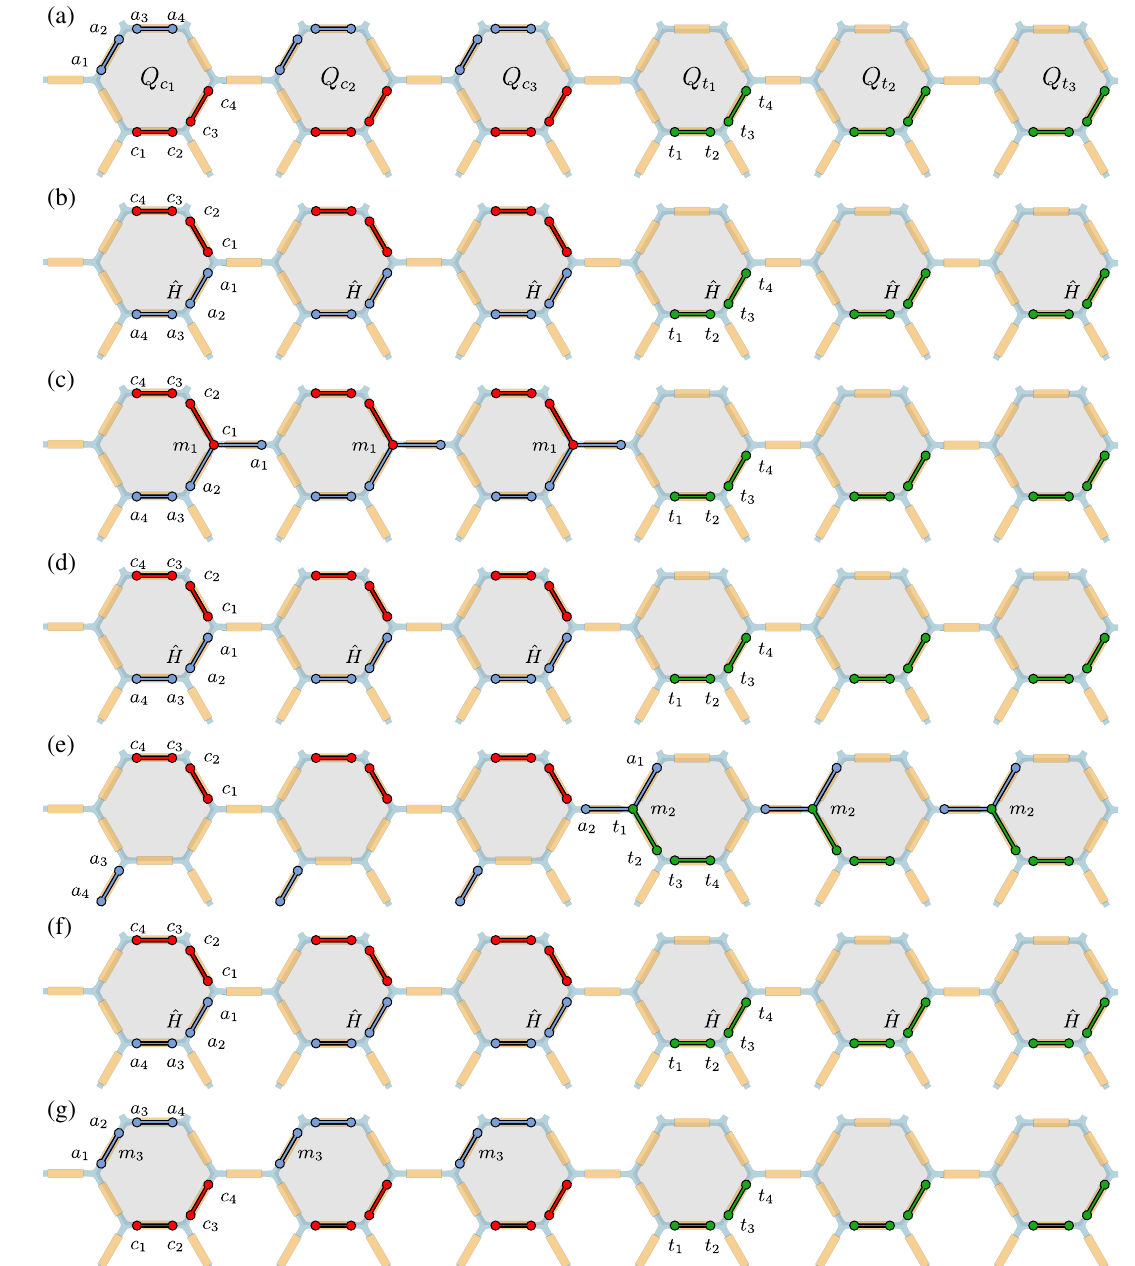
FIG. 20. Protocol for three simultaneous CNOT s between three control qubits Q and three target qubits Q using the quantum c 1 − c 3 t 1 − t 3 circuit in Fig. 4. In the cell occupied by the control qubits (red), ancillas (blue) are initialized in the j 0 i state (a) and moved to the double T junction of the cell for a Hadamard gate (b). The first two Majoranas of the control and ancilla qubits are moved onto a connected island, and the four-Majorana parity is measured (c), corresponding to a two-qubit parity measurement with outcome m 1 . The ancillas are moved back to the double T junction for another H gate (d). The third and fourth Majoranas a 3 and a 4 of each ancilla qubit are moved into the lower leg of their hexagonal cell, such that the remaining ancilla Majoranas can move to the target qubit cells for a four- Majorana parity measurement (e). The ancilla Majoranas are then moved back to the control cells for an H gate (f). Finally, all qubits return to their initial positions (g), and the ancilla qubits are measured by measuring the two-Majorana parity m 3